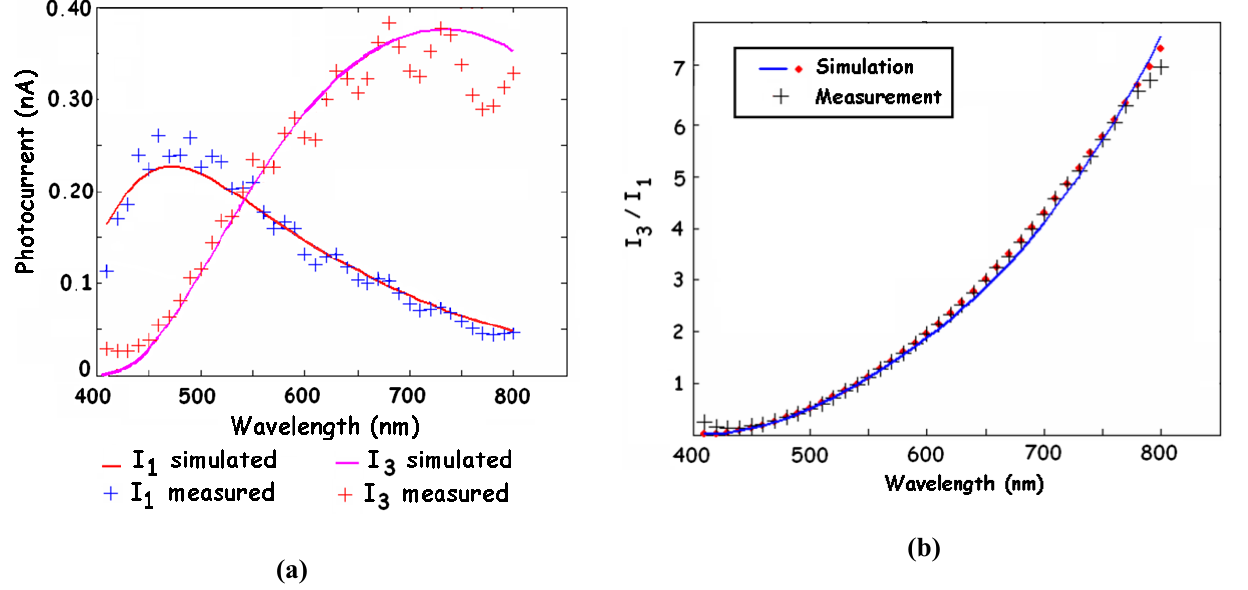
Figure 2. Spectral characteristics of a CMOS BDJ detector. (a) Spectral responses of